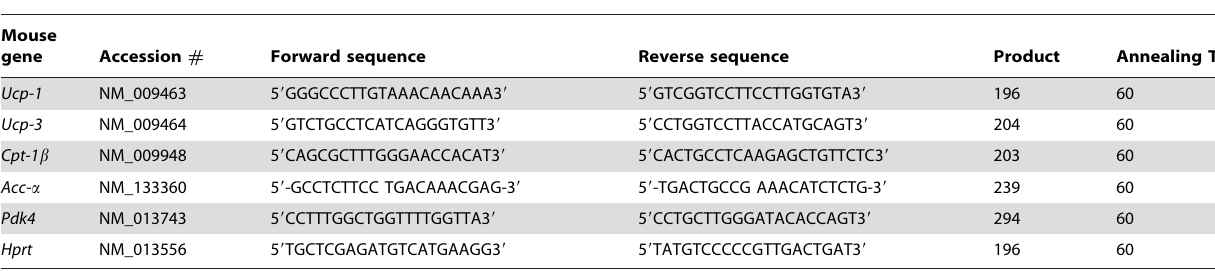
Table 1. Primer sequences for